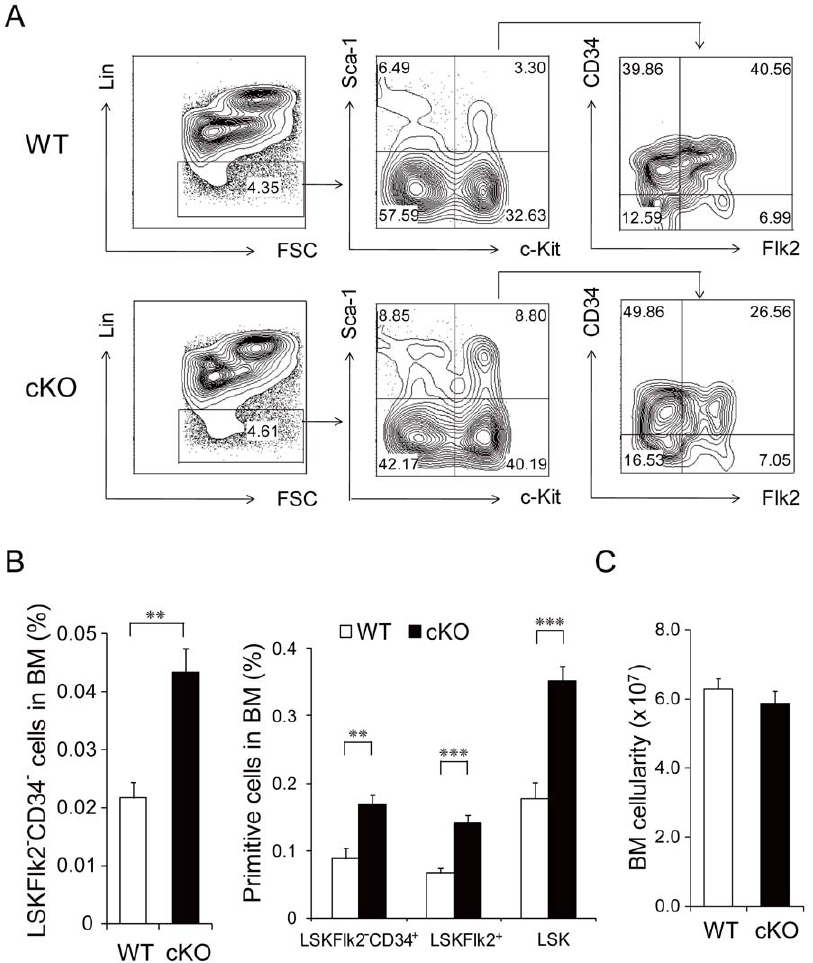
Figure 2. GRP94 deficiency in the bone marrow expanded the primitive cell pool. A) Representative flow cytometric analysis with BM cells using Lin, c-Kit, Sca-1, Flk2 and CD34. B) Quantitation of flow cytometric analysis of primitive cell proportions. Left panel shows the percentage of LSKFlk2 2 CD34 2 in BM and right panel shows LSKFlk2 2 CD34 + , LSKFlk2 + (n=5 for WT, n=8 for cKO) and total LSK (n=16 for WT, n=22 for cKO) cells in BM using Lin, c-Kit, Sca-1. C) Total BM cell number from WT (n=19) and cKO (n=20) mice (p=0.373). All data are presented as mean 6 s.e., **p , 0.01, ***p , 0.001.